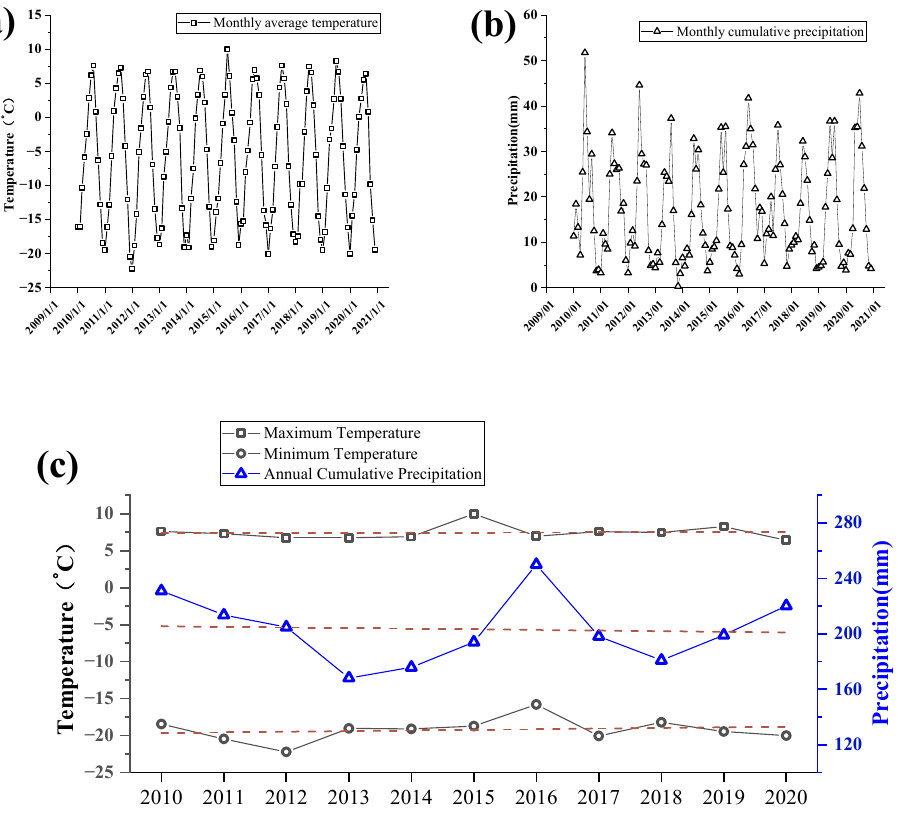
Figure 8. ( a ) Curves of monthly average temperature variations in the Lake Chatyrkul basin from 2010 to 2020. ( b ) Curves of monthly cumulative precipitation in Lake Chatyrkul basin in 2010–2020. ( c ) Curves of annual temperature extremes and annual cumulative precipitation in the Lake Chatyrkul basin in 2010–2020.